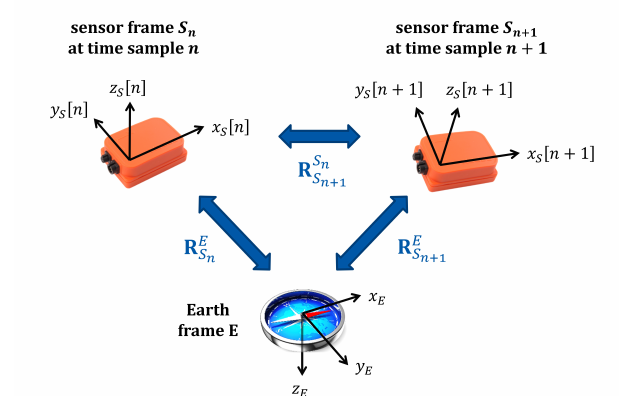
Figure 4. The Earth and the sensor coordinate frames at two consecutive time samples with the rotational transformations relating